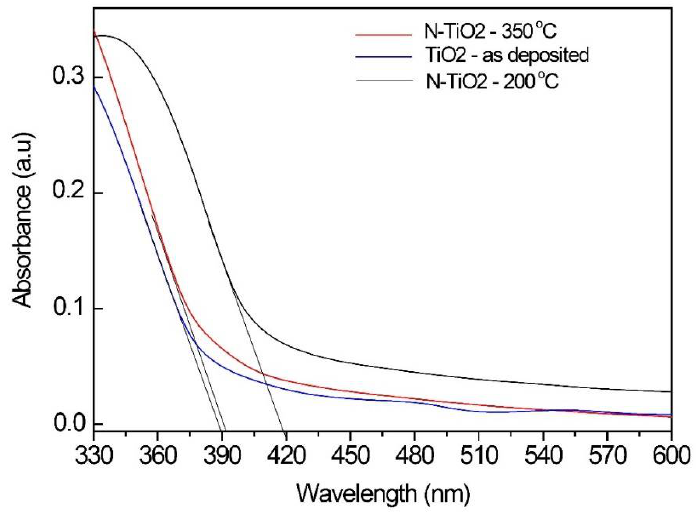
Figure 9. UV-Vis absorption spectra of (blue) a-TiO 2 film (as-deposited), (black) TiO 0.25 N 0.75 film heat-treated at 200 °C (amorphous N-TiO 2 ), and (red) TiO 0.25 N 0.75 film heat-treated at 350 °C (anatase nanocrystals precipitated in amorphous